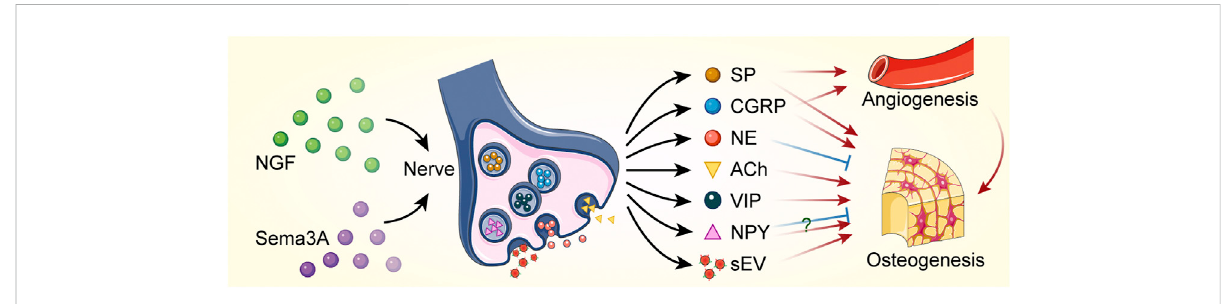
FIGURE 3 Bone regeneration is regulated by nerves through paracrine action. Nerve growth factor (NGF) and semaphorin 3A (Sema3A) promote nerve regeneration. Neurotransmitters and small extracellular vesicles (sEVs) are released by neural cells to regulate angiogenesis and osteogenesis. Red sharp arrows ( → ) indicate stimulation, while blue blunt arrows ( ┴ ) indicate inhibition. The role of neuropeptide Y (NPY) in regulating bone formation remains controversial. SP, substance P; CGRP, calcitonin gene-related peptide; NE, norepinephrine; ACh, acetylcholine; VIP, vasoactive intestinal